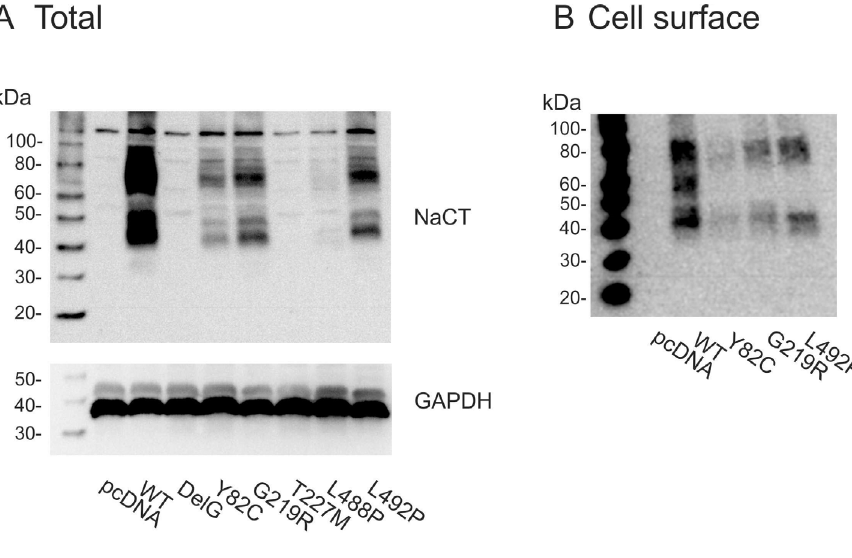
Figure 3. Western blots. (A) Total cell protein. Protein lysates from COS-7 cells transfected with empty vector, pcDNA, wild-type NaCT (WT) and mutants. Duplicate blots were probed with anti-NaCT (top) and GAPDH antibodies (bottom). Size standards (kDa) are shown at left. (B) Cell surface biotinylated proteins from HEK-293 cells treated with mem- brane-impermeant sulfo-NHS-LC-biotin followed by streptavidin beads. The HEK-293 cells were used for biotinylations because the signal was stronger than with COS-7 codon and would be undetectable using also examined cell surface expression our antibodies because the early stop of the mutants by biotinylation with codon is before the antigenic site. We a membrane-impermeant reagent,